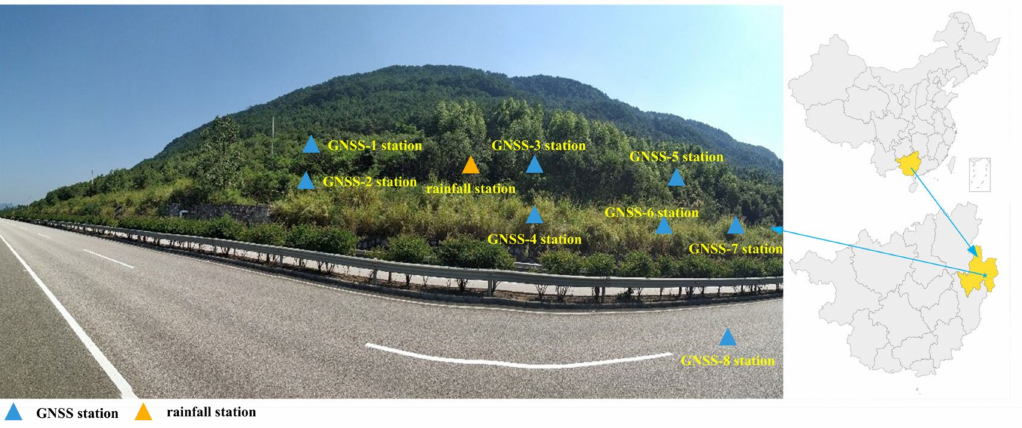
Figure 4. A photograph of the Zhongma landslide ( left ) and the location of the study area in China ( right